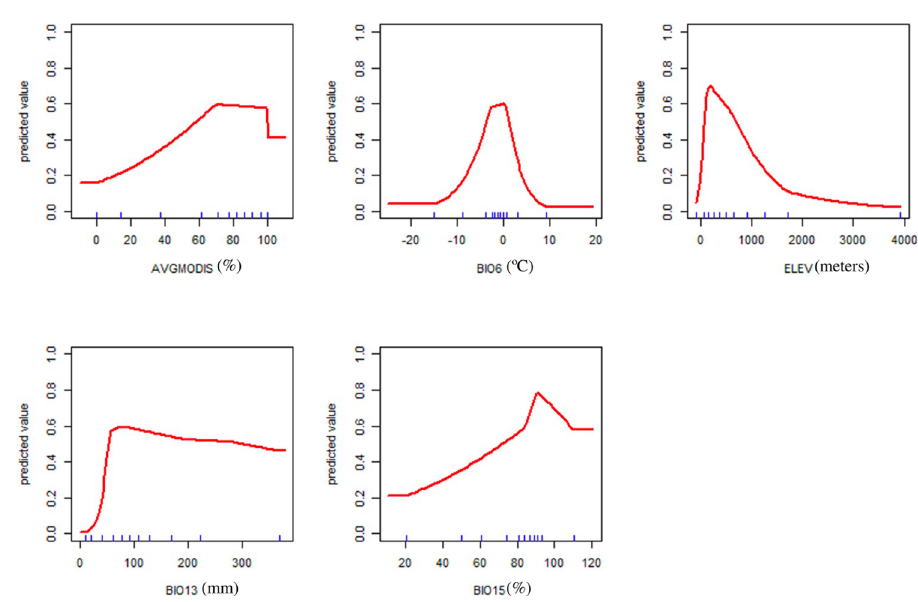
Fig 3. MaxEnt response curves for the five significant variables used in the final MaxEnt model. The response curves generated by MaxEnt show the predicted probability of suitable feral pig habitat for each individual variable per each level of the predictor. Significant layers included the minimum temperature of the coldest month (BIO6), the annual maximum green vegetation fraction (AVGMODIS), the precipitation of the wettest month (BIO13), the variation of annual precipitation (BIO15) and